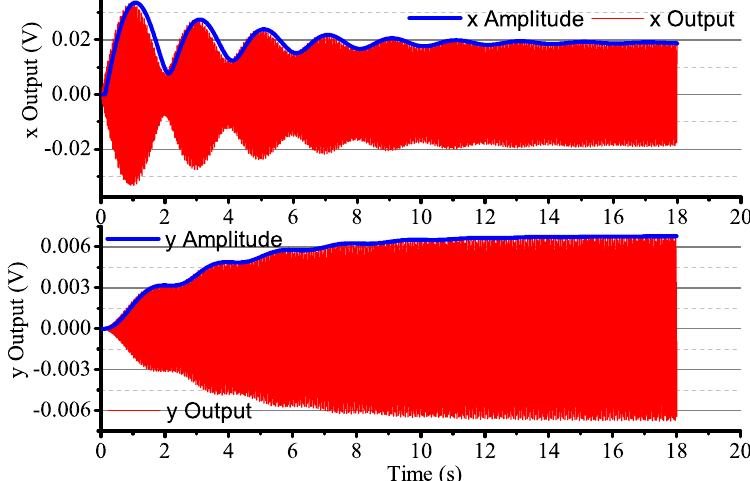
Figure 16. The gyro’s output with non-control in Ω = 0